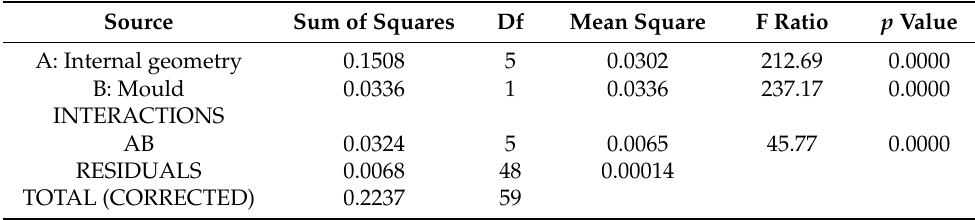
Table 7. ANOVA for ∆